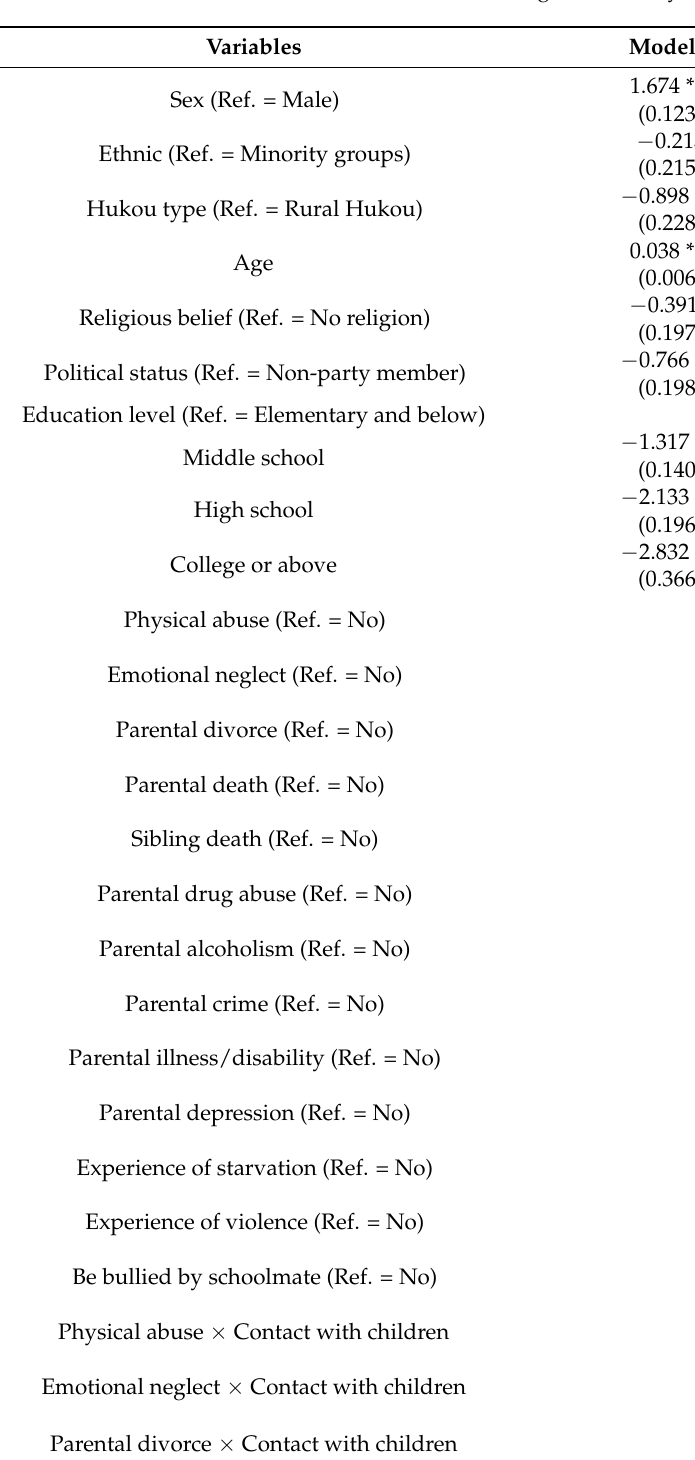
Table 5. Results of OLS regression analysis (N =